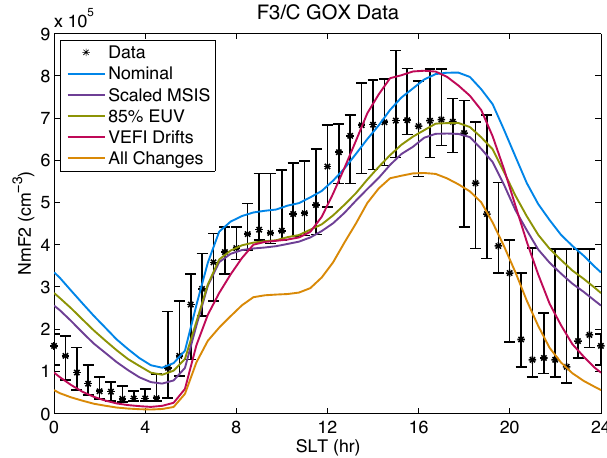
Fig. 6. The average H + density as measured by CINDI at 625km Fig. 7. The median Nm F2 values derived from F3/C, with the ver- altitude as a function of local time. The colored lines represent the tical bars representing the upper and lower quartiles. The modeled H + density as measured by CINDI at 625 km altitude as a function of local time. The Fig. 6. The average predicted densities based on the different SAMI2 runs. The vertical Fig. 7. The median N m F 2 values derived from F3/C, with the vertical bars representing the upper and lower results are the same as Fig. bars represent standard deviations. colored lines represent the predicted densities based on the different SAMI2 runs. The vertical bars represent quartiles. The modeled results are the same as Figure 4. standard deviations.